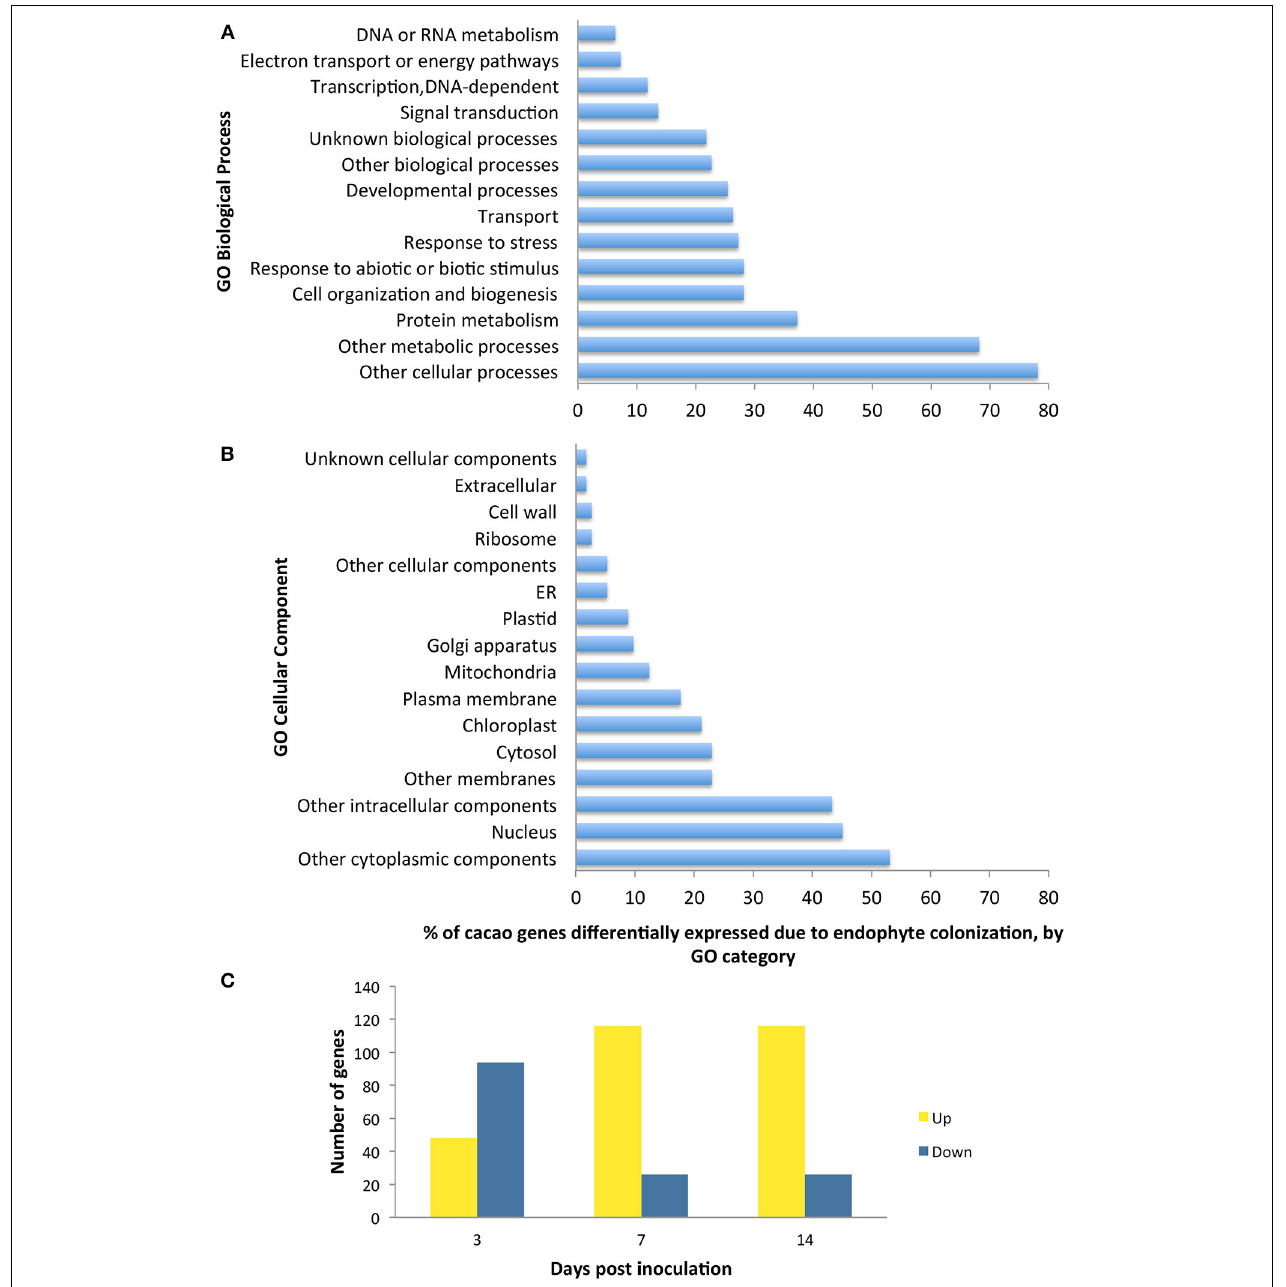
FIGURE 2 | Functional GO categorization of T. cacao genes with significant changes in expression due to endophyte C. tropicale inoculation across four time points evaluated during 2 weeks post inoculation. A total of 142 genes showed significant difference in expression ( F -test ANOVA, p < 0 . 05 after FDR correction). (A) Genes sorted by Biological process terms; (B) Genes sorted by Cellular